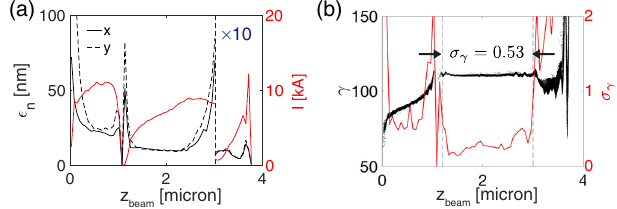
FIG. 5. The simulation results in a laser driven density ramp ¼ 0 . 18 mm. injection. (a) The emittance and the current at z plasma The black lines are the emittance and the red line is the current. (b) The longitudinal phase space (black dots) and the slice energy ¼ 0 . 18 mm. Note that about 94% spread (red line) at z plasma electrons are contained when calculated the beam parameters and the whole beam is divided into 64